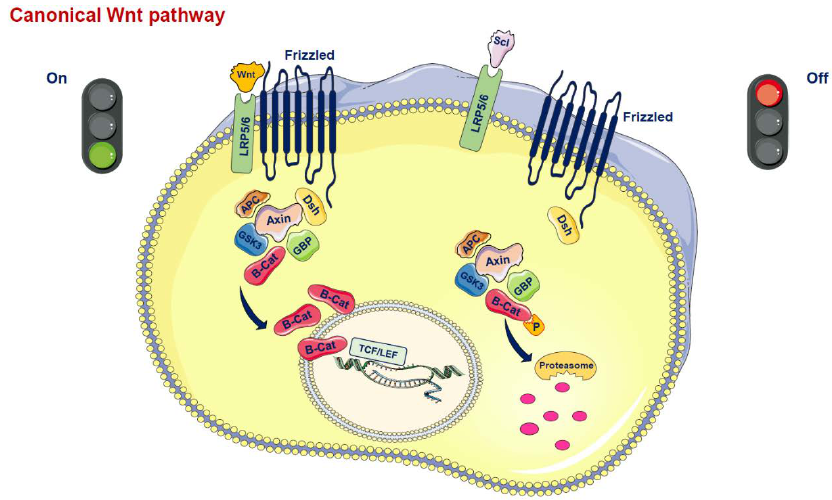
Figure 1. Canonical Wnt pathway. In the active state, Wnt ligands (Wnt) form a complex with the receptors low-density lipoprotein receptor-related protein 5 or 6 (LRP5/6) and Frizzled (Fz). Disheveled (Dsh) is then able to bind to Fz. Dsh forms a complex with glycogen synthase kinase 3ß (GSK3ß), GSK3 binding protein (GBP), axin and adenomatous polyposis coli (APC). This protects ß-catenin from proteasomal degradation. ß-catenin translocates into the nucleus and interacts with the T-cell factor/lymphoid enhancer factor (TCF/LEF) family of transcription factors to promote gene transcription. In the inactive state, inhibitors of this system, such as Sclerostin (SCL), prevent the formation of the Wnt-Fz-LRP5/6 complex. ß-catenin is degraded by proteasomes after GSK3ß-mediated phosphorylation, so the signal is stopped.